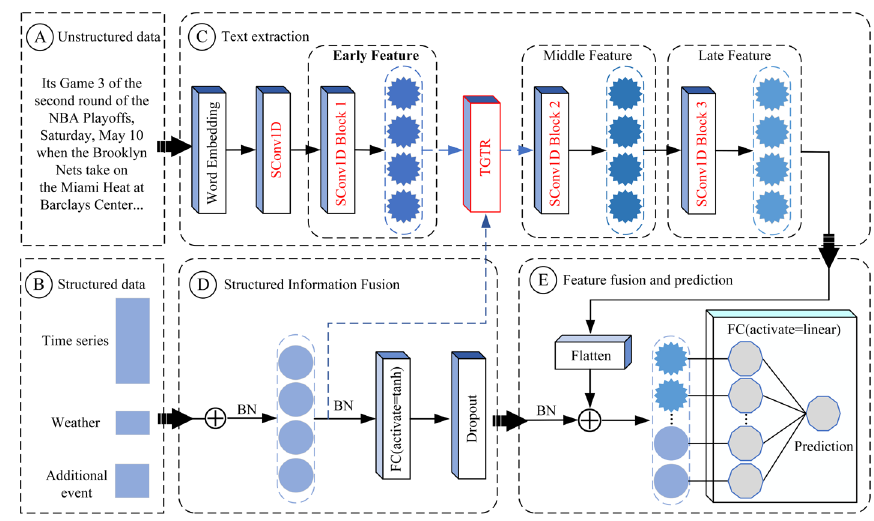
Fig. 3 FFN (SConv1D earlyTGTR) schematic diagram and network +